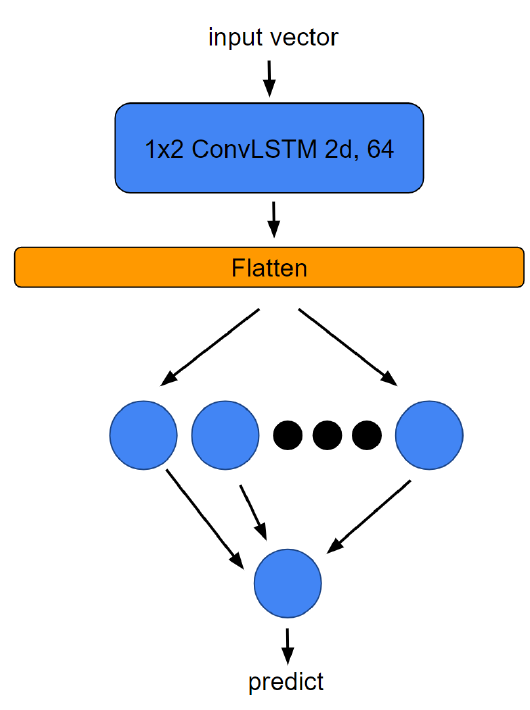
Figure 2. Conv-LSTM architecture.